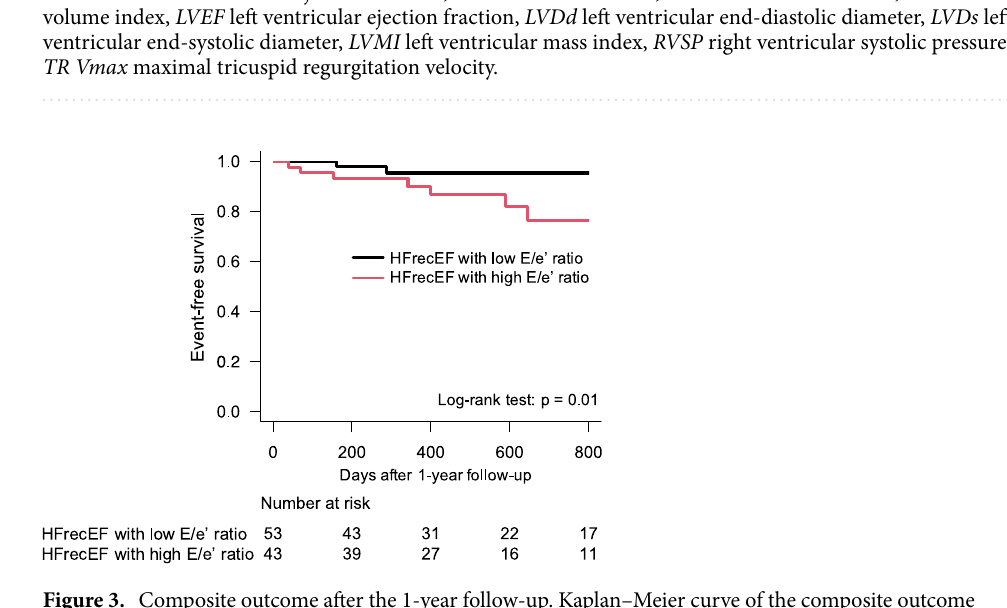
Figure 3. Composite outcome after the 1-year follow-up. Kaplan–Meier curve of the composite outcome between the two groups categorized according to the E/e ′ ratio at the 1-year follow-up using a cutoff score of 12.1. E/e ′ = peak velocity of the early wave (E) to early diastole (e ′